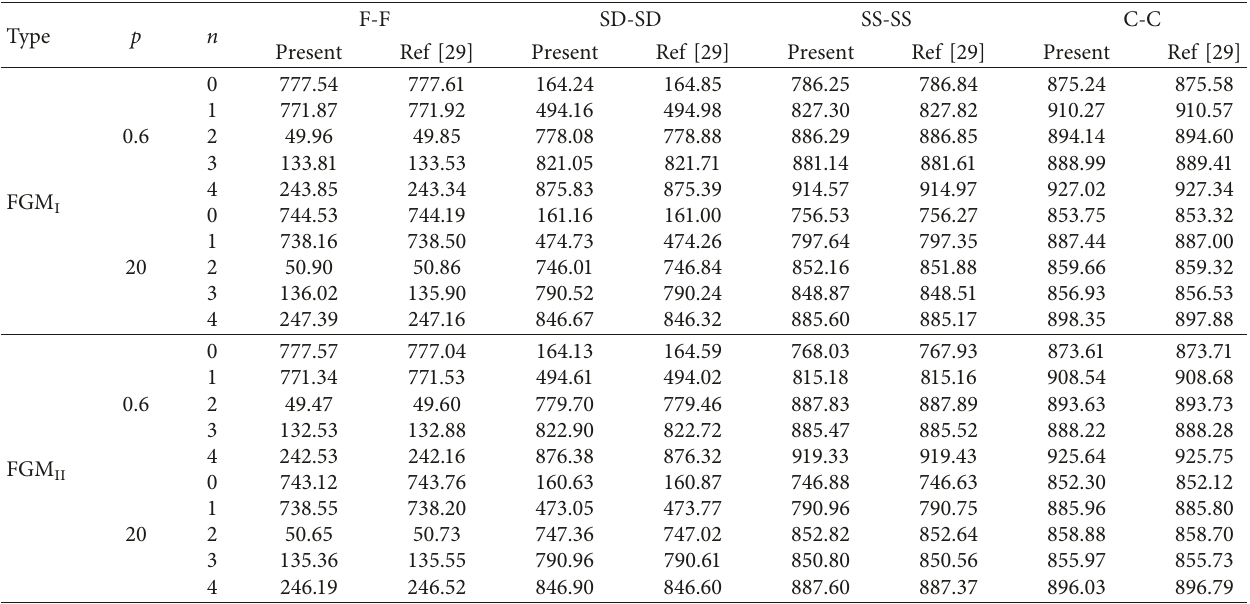
Table 2: Comparison of frequency with general boundary restraints.